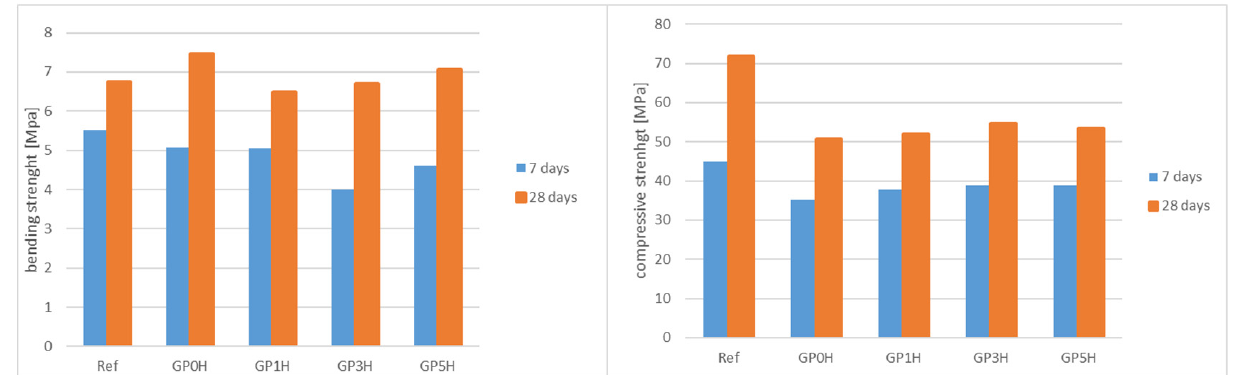
Figure 6. Bending and compressive mechanical strengths in hardened pastes modified with granite powder with respect to a reference sample.